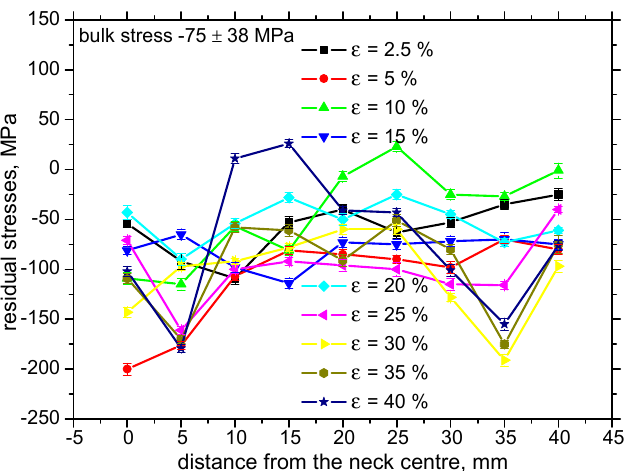
Figure 10. True stresses versus residual stresses. Materials 2020 , 13 , x FOR PEER REVIEW